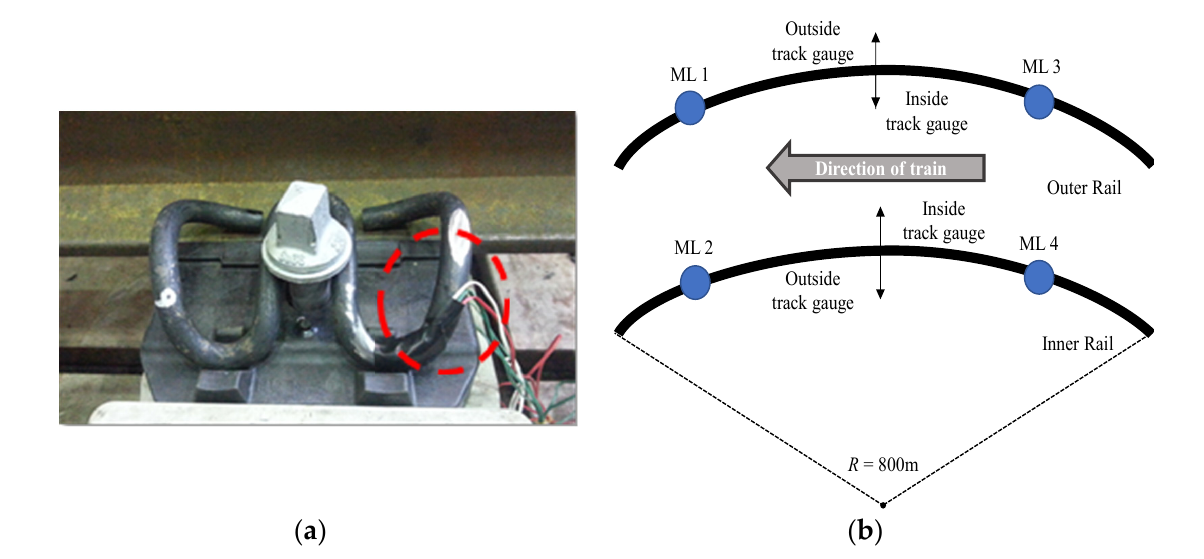
Figure 3. The strain gauge used and the measurement locations (MLs): ( a ) The attachment of the rosette strain gauge to the tension clamp; ( b ) the MLs on the railway track.